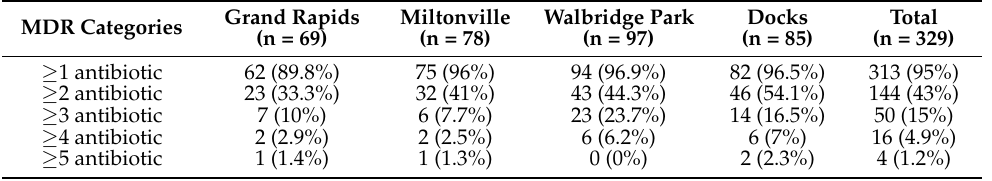
Table 3. Number of MDR E. coli isolates (%) expressing resistance to ≥ 1, ≥ 2, ≥ 3, ≥ 4 and ≥ 5 antibi- otics, across all sampling events. Total isolate numbers are in parentheses under each sampling